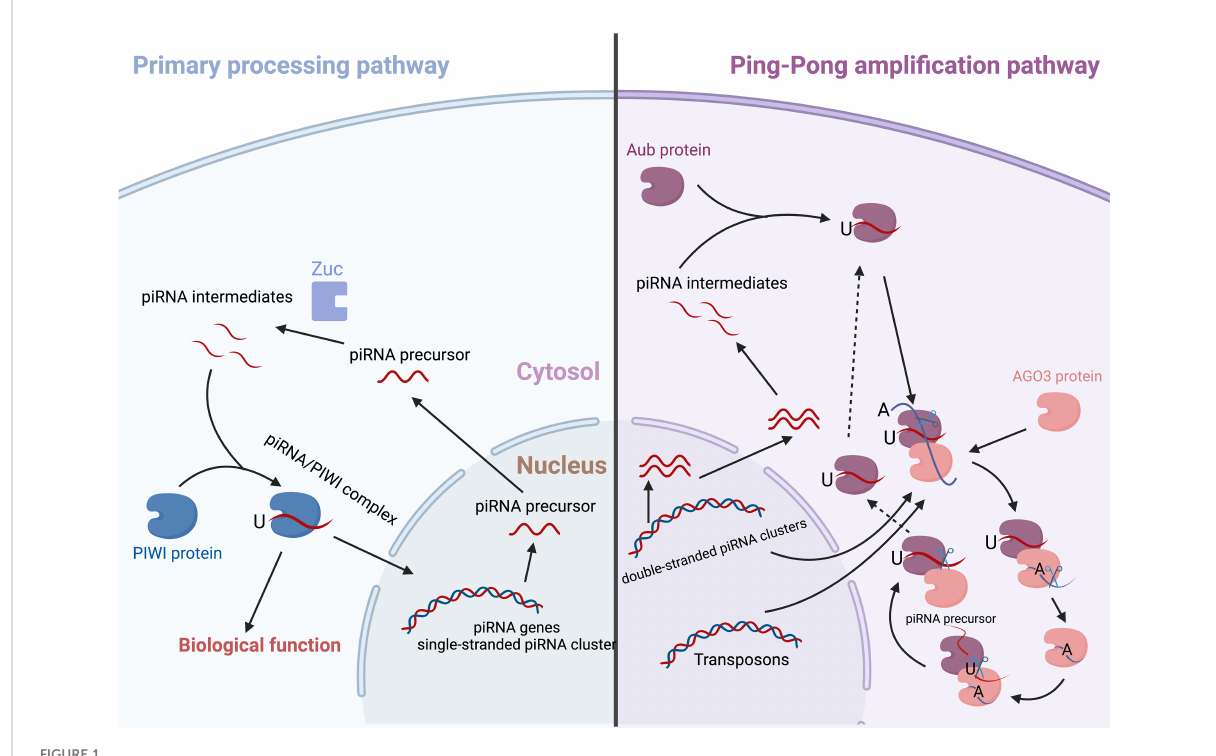
FIGURE 1 The biogenesis of piRNA/PIWI